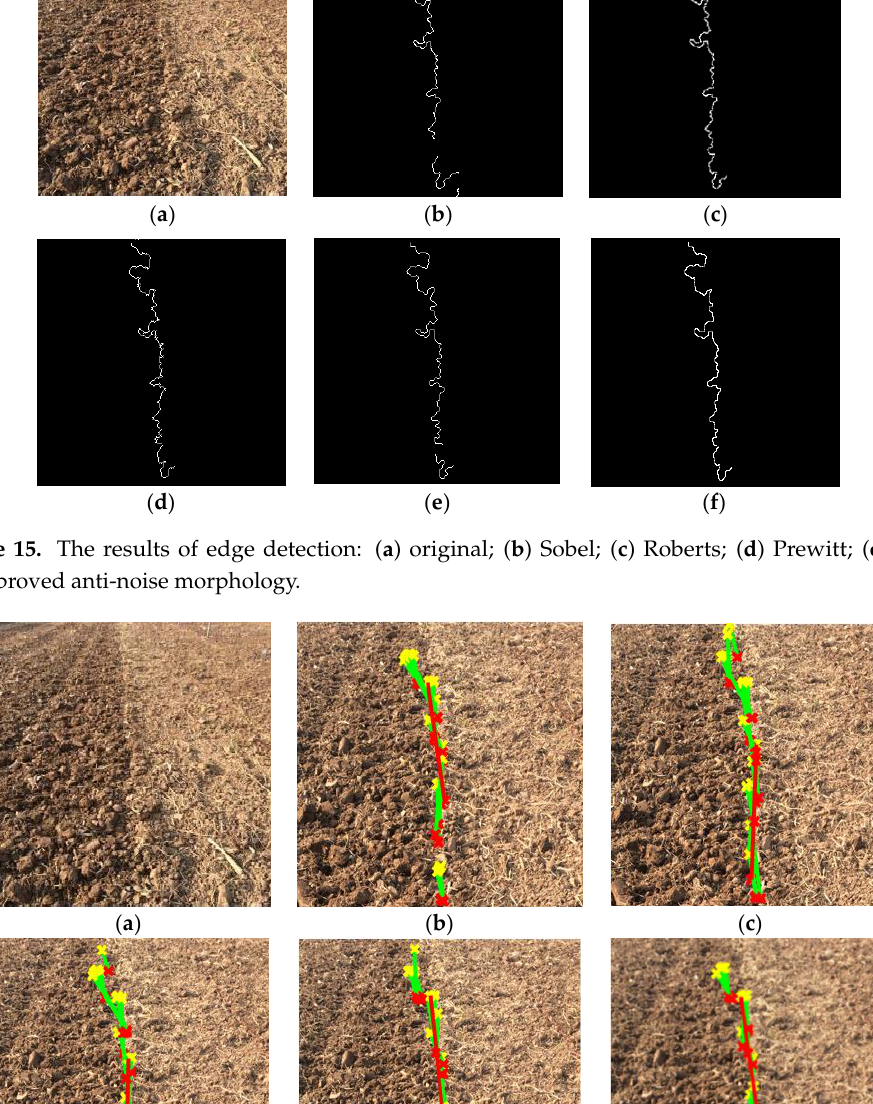
Table 3. Time consumption contrast of different edge operators.